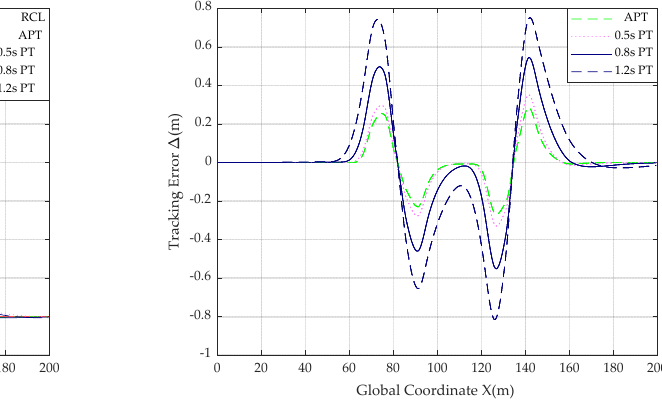
( b ) Comparison of tracking error at 20 m/s with dif ‐ Figure 22. Comparison of trajectories and tracking error with different preview times at 20 m/s. Table 6. Maximum offsets and minimum offsets for different preview times and different speeds for road segment three.